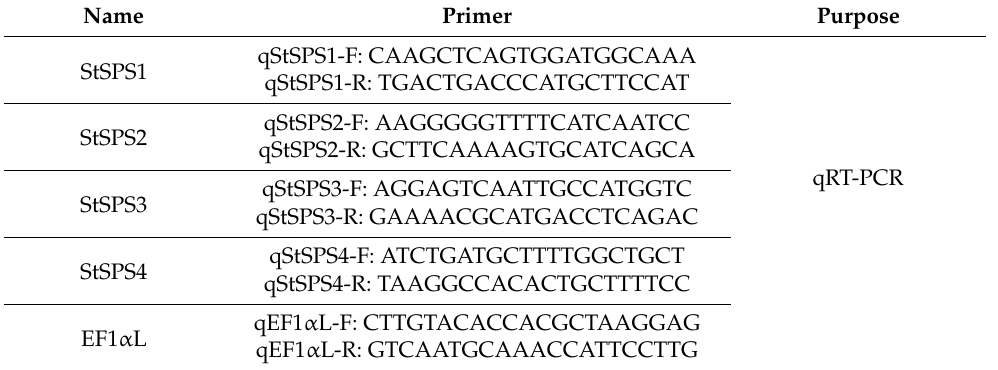
Table 1. Primer information. EF1 α L is an internal reference gene. F represents forward primer, and R represents reverse